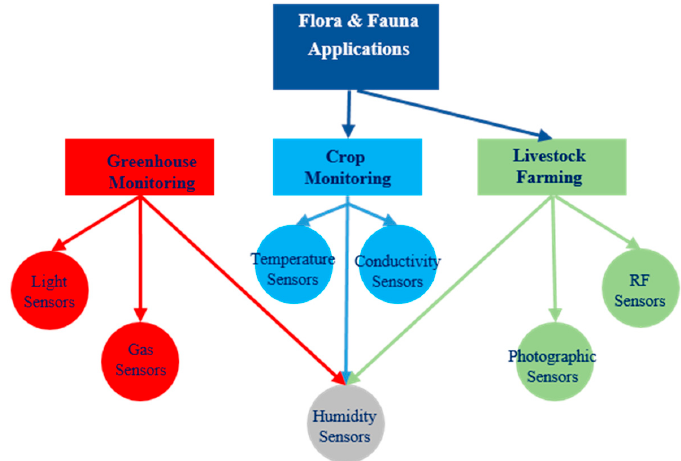
Figure 12. The subcategories of flora and fauna applications of WSNs and the types of the sensors used in them.